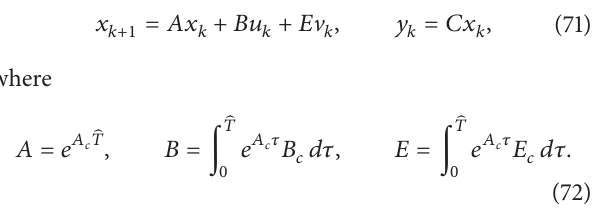
Figure 2: Open- and closed-loop systems for the hydraulic turbine model of Example